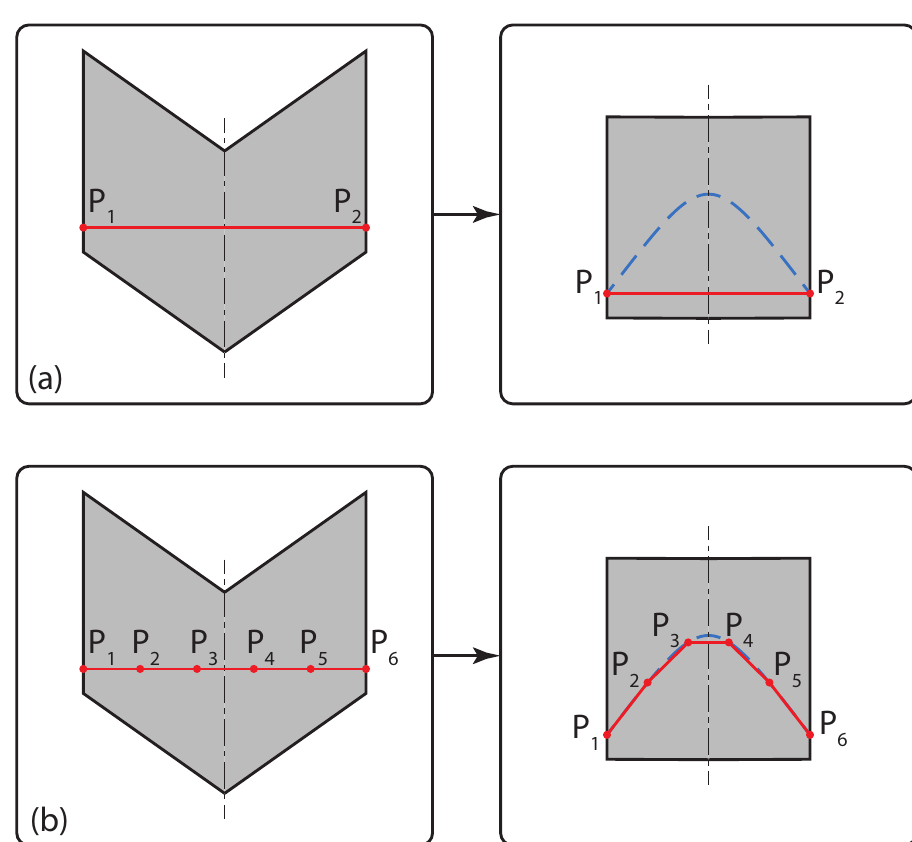
Figure 9. Splitting of elements to achieve proper accuracy. In ( a ) long elements are not split, while in ( b ) the element is split in 5